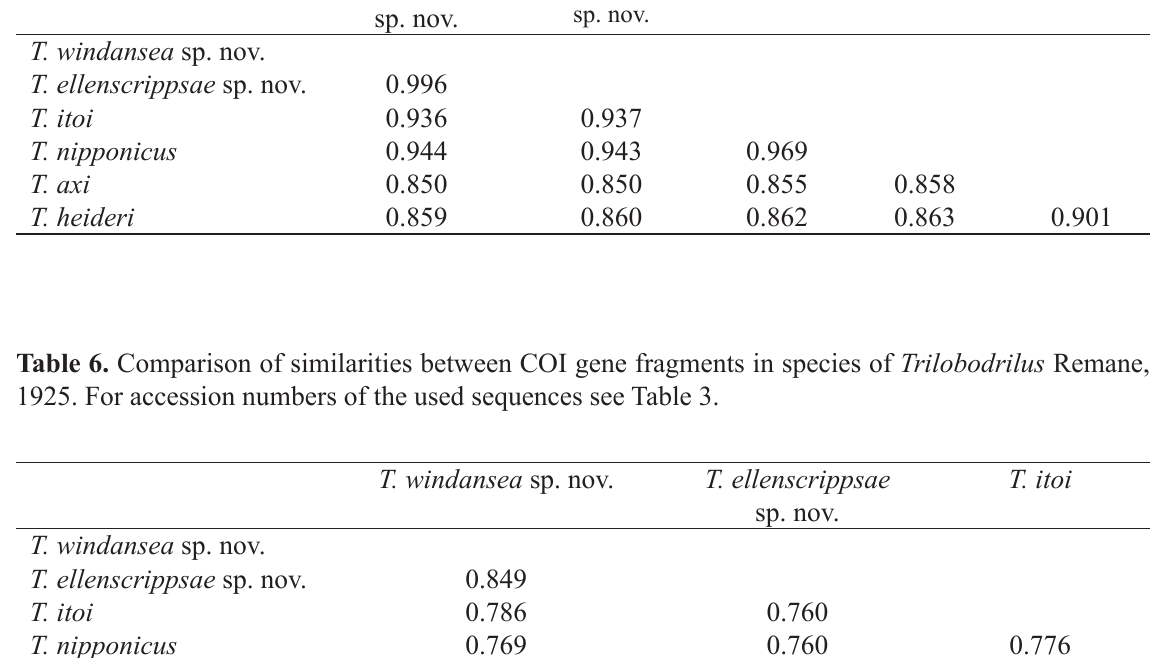
Table 7 (next page). Morphological characters and their states in all described species of Trilobodrilus Remane, 1925. Measurements are given in mm for body length and width, and in µm for the size of epidermal inclusions; the latter are taken from Kajihara et al. (2015), and from the original sources (Rao 1973; Remane 1925; Riser 1999; Uchida & Okuda 1943; Westheide 1967, 2008). Abbreviations: G = gonochoristic; H =